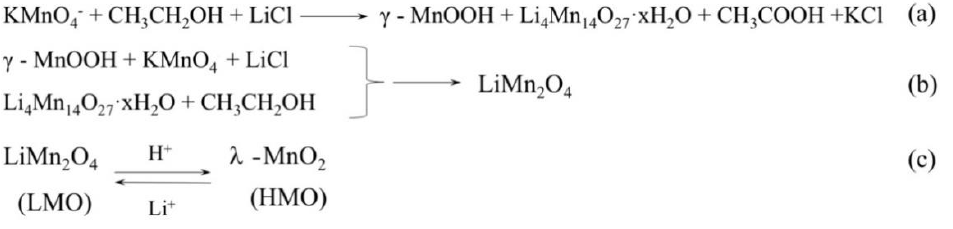
Figure 3. Synthetic mechanisms: ( a , b ) synthesis of LMO; ( c ) absorption-desorption mechanism of λ -MnO 2 (HMO) and LMO.